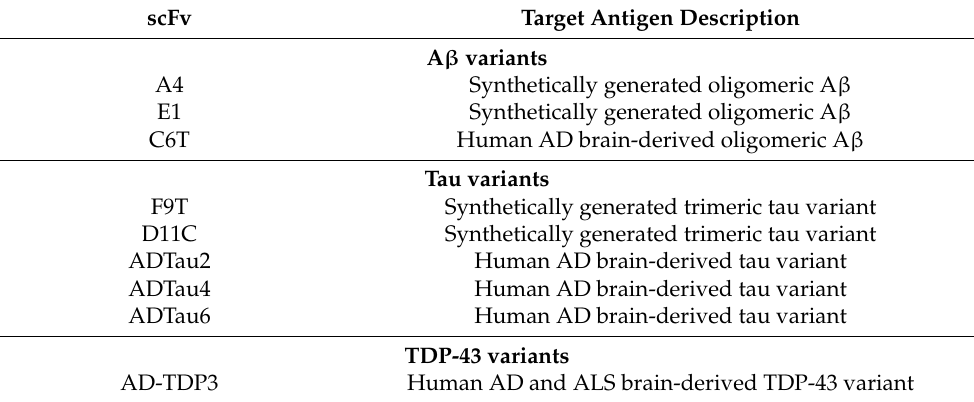
Table 1. List of scFvs and their target